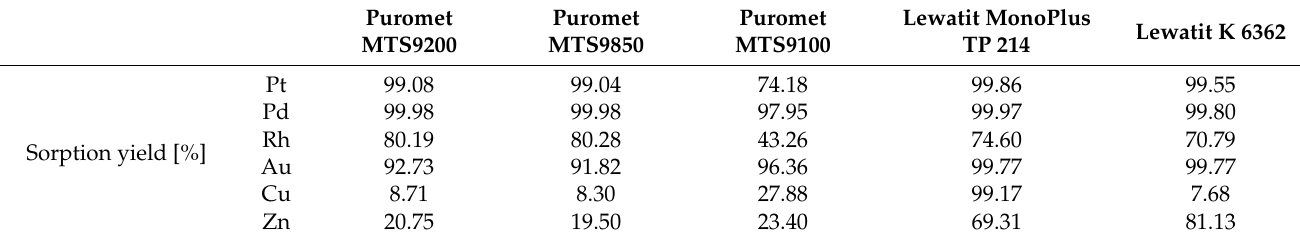
Table 4. Sorption yields of the individual elements after the preliminary sorption